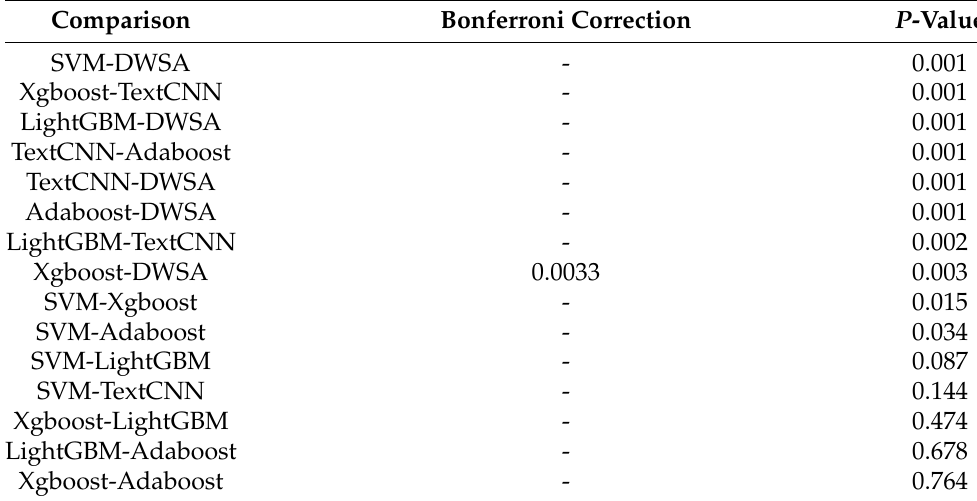
Table 2. The statistical comparison between the proposed method and other algorithms. The significance level is 0.05. After the Bonferroni correction, the significance level is 0.0033.